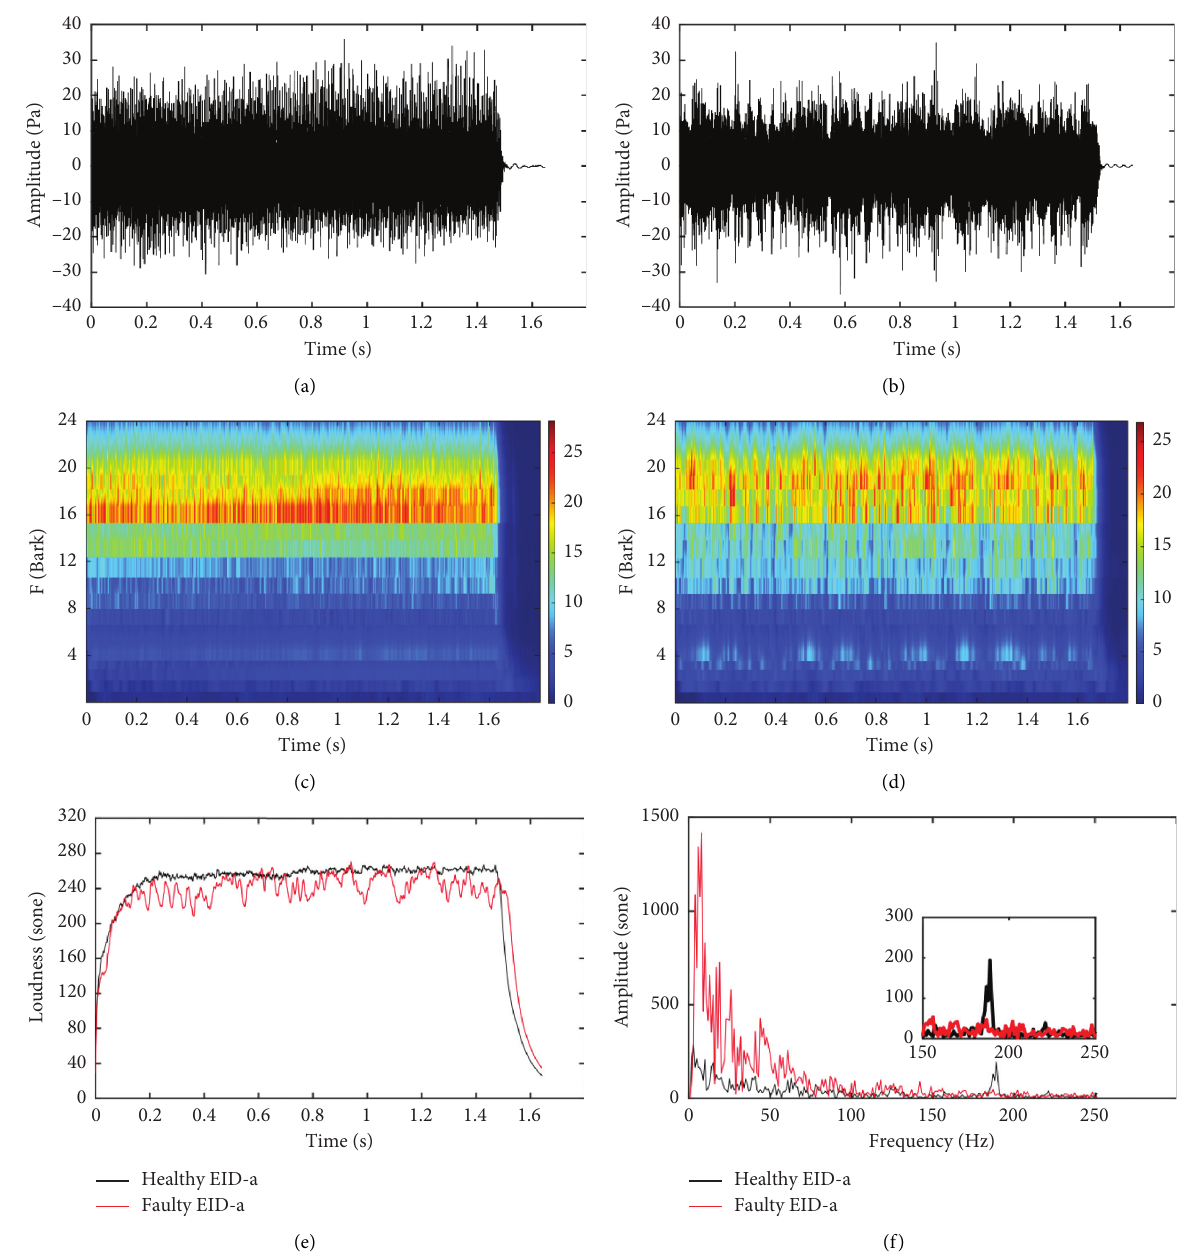
Figure 7: Acoustic signal analysis of Case 1: (a) acoustic signal of healthy EID-a, (b) acoustic signal of faulty EID-a, (c) time-varying specific loudness of healthy EID-a, (d) time-varying specific loudness of faulty EID-a, (e) time-varying loudness of healthy EID-a and faulty EID-a, and (f) time-varying loudness spectrum of healthy EID-a and faulty